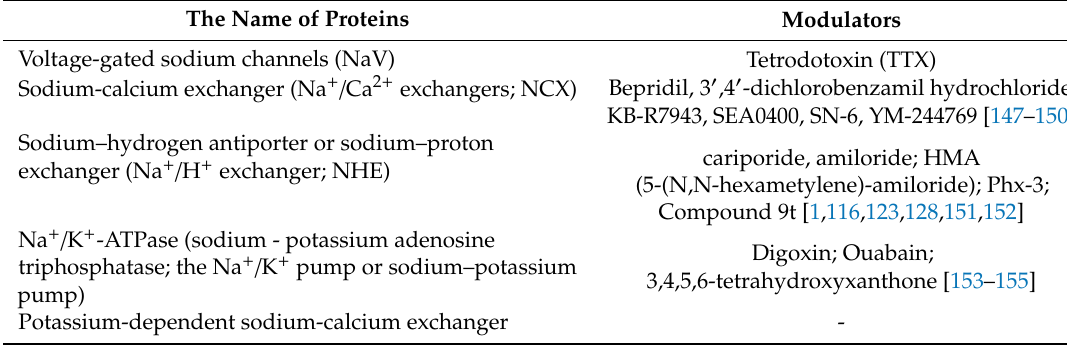
Table 2. Proteins that regulate sodium ion dynamics involved in carcinogenesis with potential